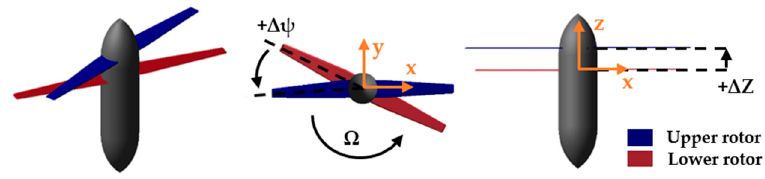
Figure 3. Index angle ( ΔΨ ) and axial spacing ( Δ Z) for coaxial co-rotating rotor.